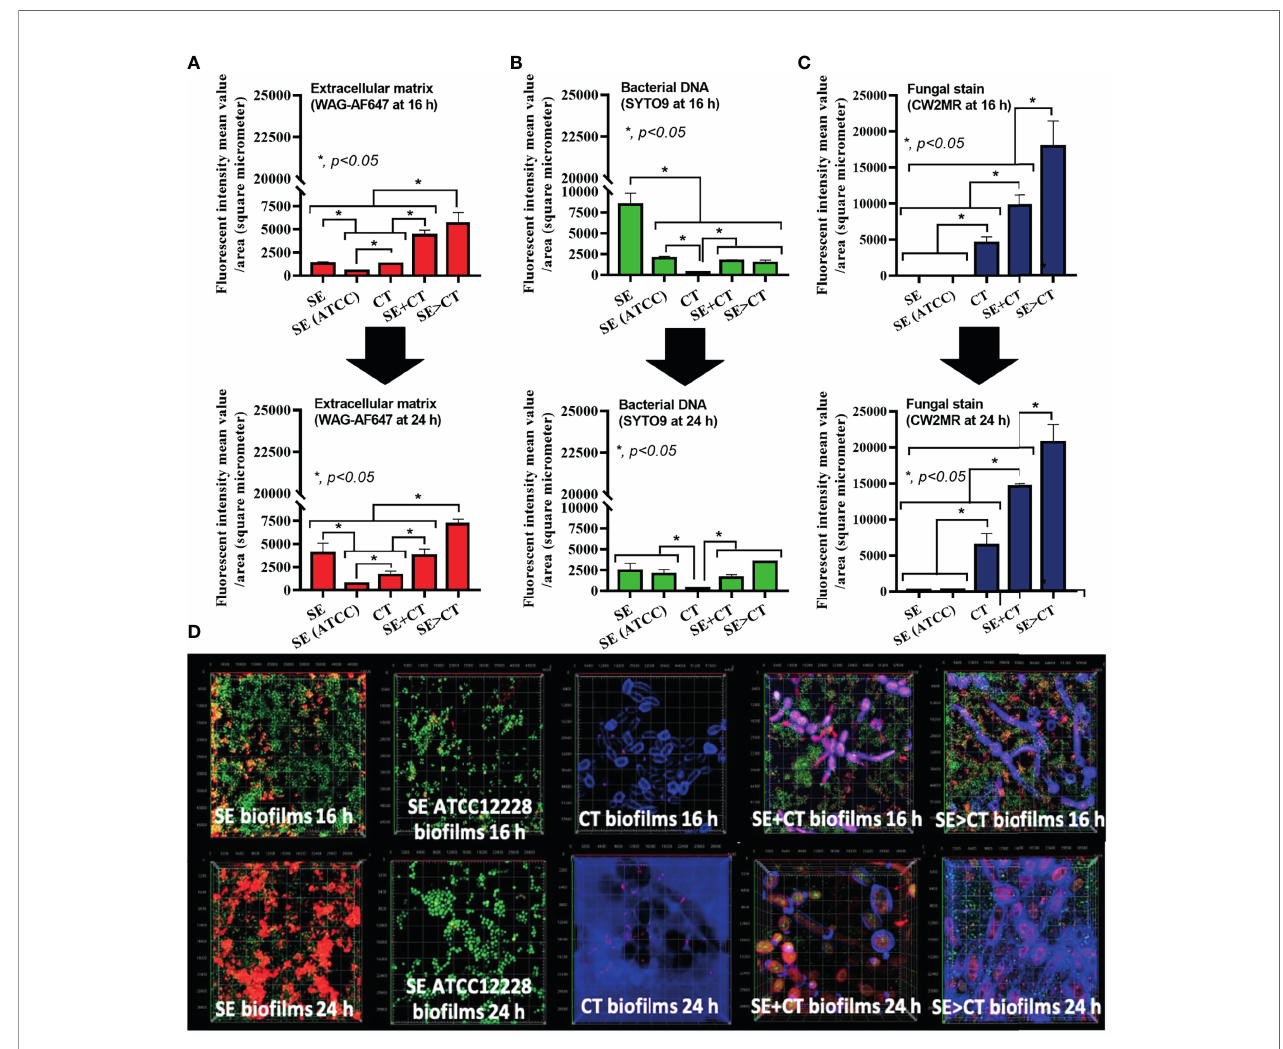
FIGURE 2 | Characteristics of bio fi lms from Staphylococcus epidermidis (SE) using the clinically isolated strain (SE) or the standard strain [SE (ATCC)], Candida tropicalis (CT), SE simultaneously mixed with CT (SE + CT), and preformed SE bio fi lms following by CT (SE > CT) as determined by intensity of fl uorescent stains from cover-glass bio fi lms at 16 h (top) and 24 h (bottom) using wheat germ agglutinin (WAG)-AF647 (red color fl uorescence) for extracellular matrix (A) , SYTO9 (green color fl uorescence) for bacterial nucleic acid (B) , and calco fl uor white (CW2MR) (blue color fl uorescence) for fungal cell wall (C) , with the representative fl uorescent images (D) demonstrated (independent triplicate experiments were performed). The results were from three independent experiments in triplicate as the mean ± SEM; p < 0.05 was considered statistically signi fi